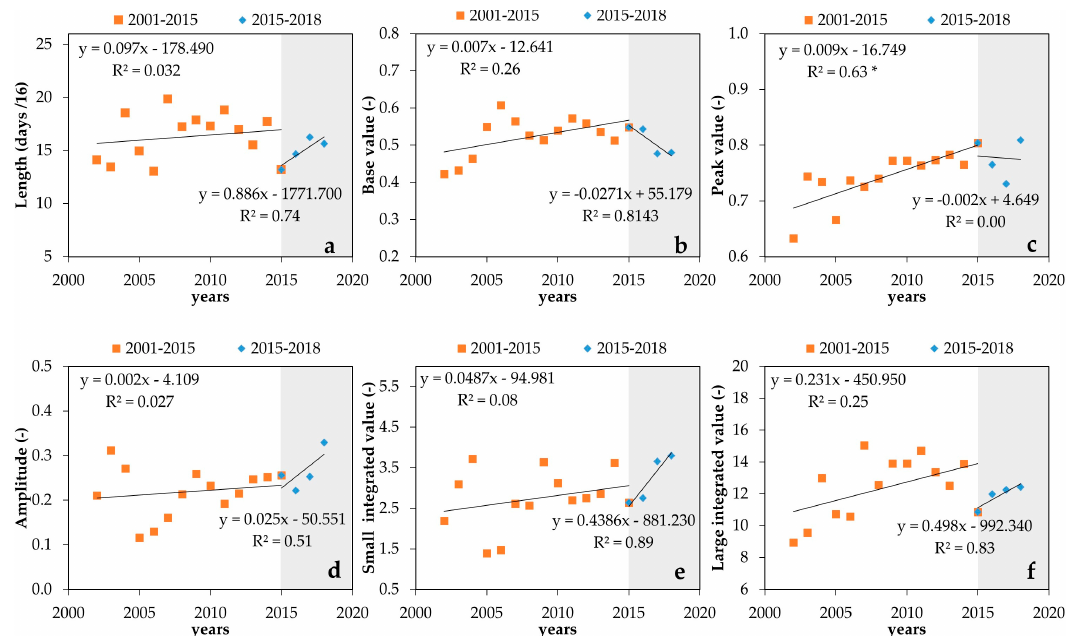
Figure 10. Seasonal parameters in CS3: ( a ) length value, ( b ) base value, ( c ) peak value, ( d ) amplitude value, ( e ) small seasonal integral and ( f ) large seasonal integral. The grey areas refer to the time interval when corrective measures have been implemented for facing CTV. Significant p -value ( p < 0.05, 0.01 and 0.001) are indicated with *, ** and ***, respectively.